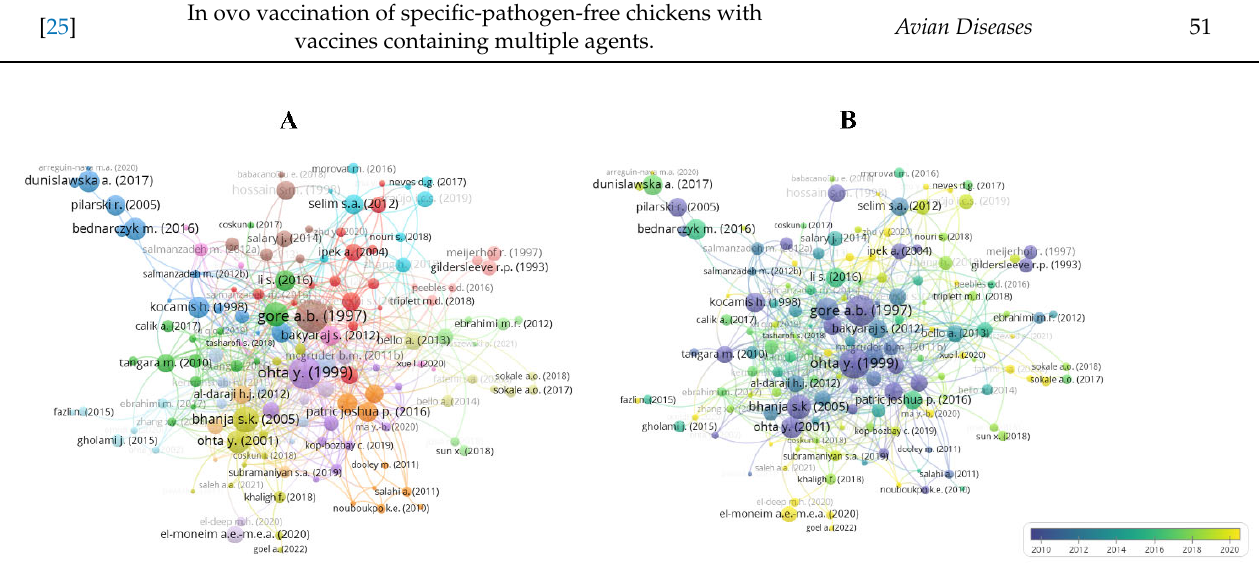
Figure 3. Citation-based document network. Table 2. The 10 most cited studies between 1985 to 2023.